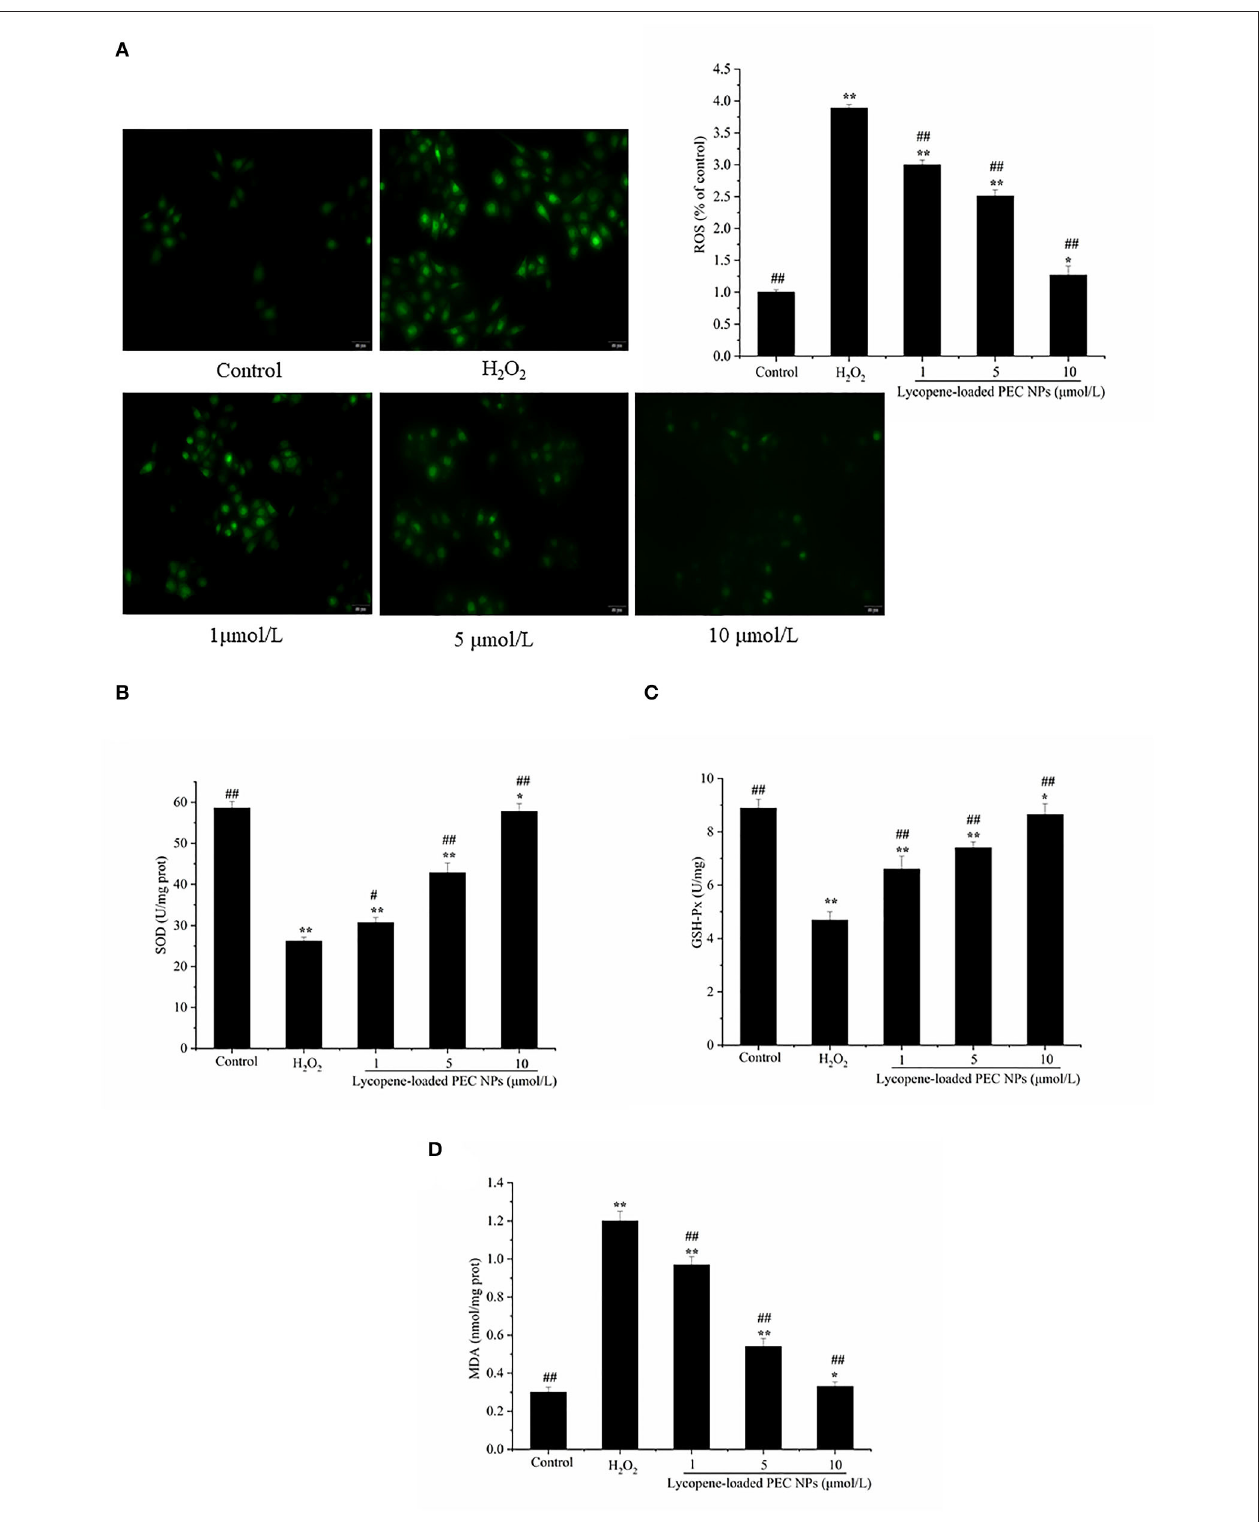
FIGURE 11 | Lycopene-loaded PEC NPs alleviate H 2 O 2 -induced oxidative stress. (A) Effect of lycopene-loaded PEC NPs on H 2 O 2 -induced ROS generation in cells. The fluorescence increase meant that DCF was indicative of enhanced ROS generation. (B) Effect of lycopene-loaded PEC NPs on SOD activity. (C) Effect of lycopene-loaded PEC NPs on GSH-Px level. (D) Effect of lycopene-loaded PEC NPs on MDA level. Data (mean ± SD) represent three experimental replicates. * p < 0.05, ** p < 0.01, vs. control group. # p < 0.05, ## p < 0.01, vs. H 2 O 2 -treated group.